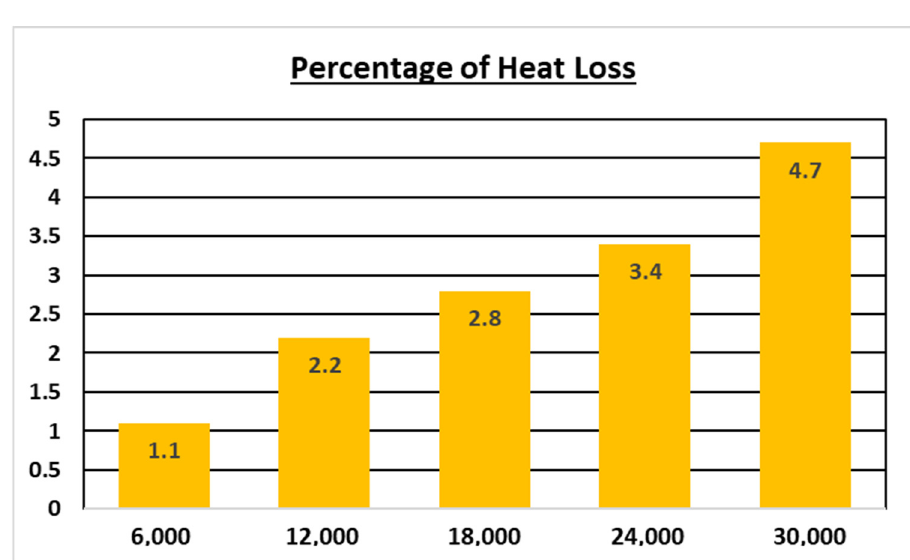
Figure 6. Percentage of Heat Loss across different Re.